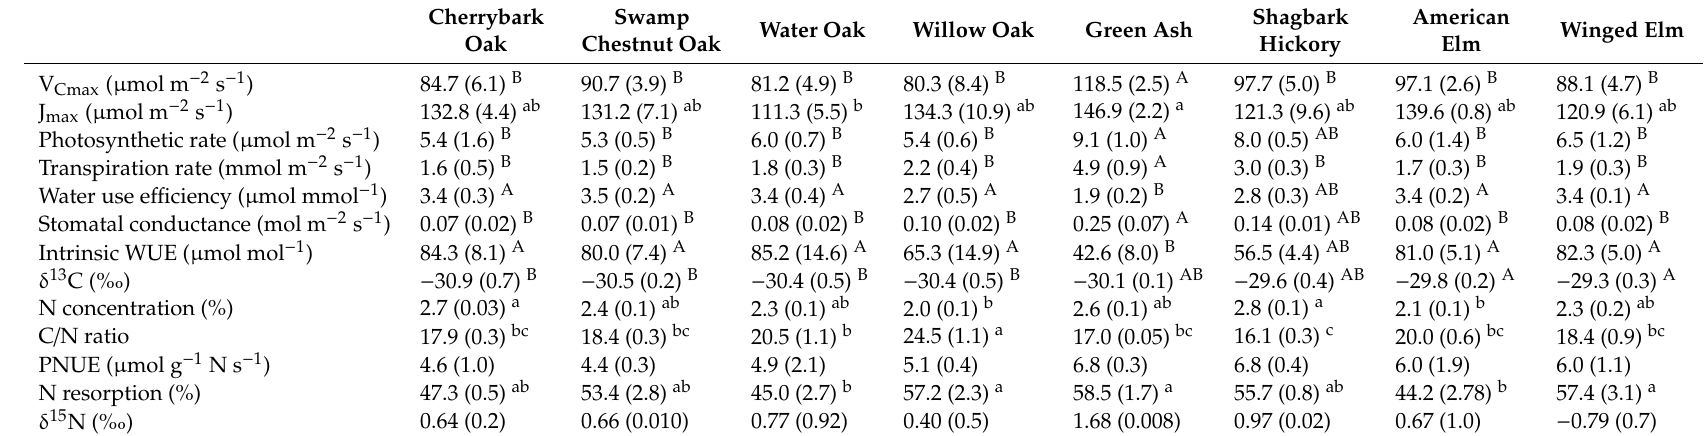
Table 1. Mean (standard error in parentheses) leaf carbon assimilation, water use and nutrient parameters for bottomland hardwood study species. Cherrybark